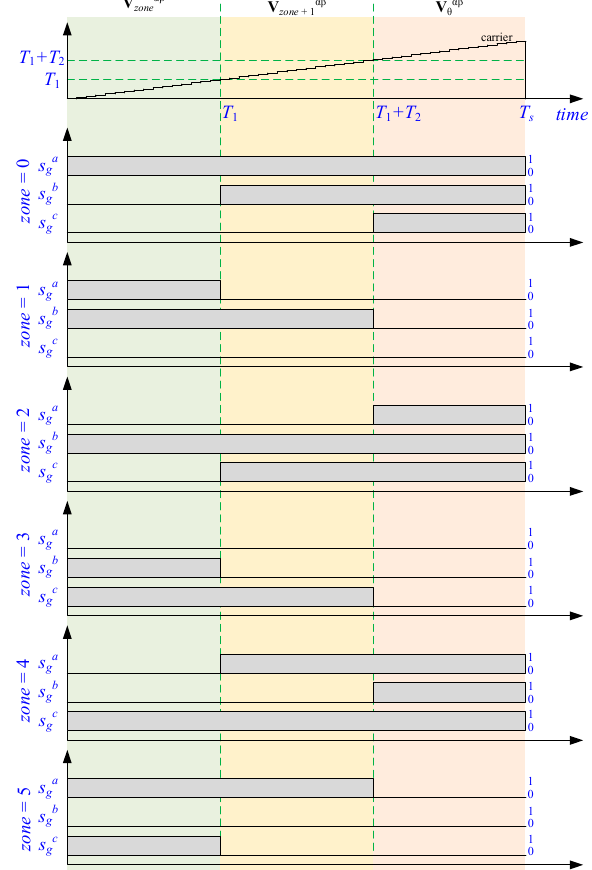
Figure 4. One period of selected pulses as a function of T 1 , T 2, and the